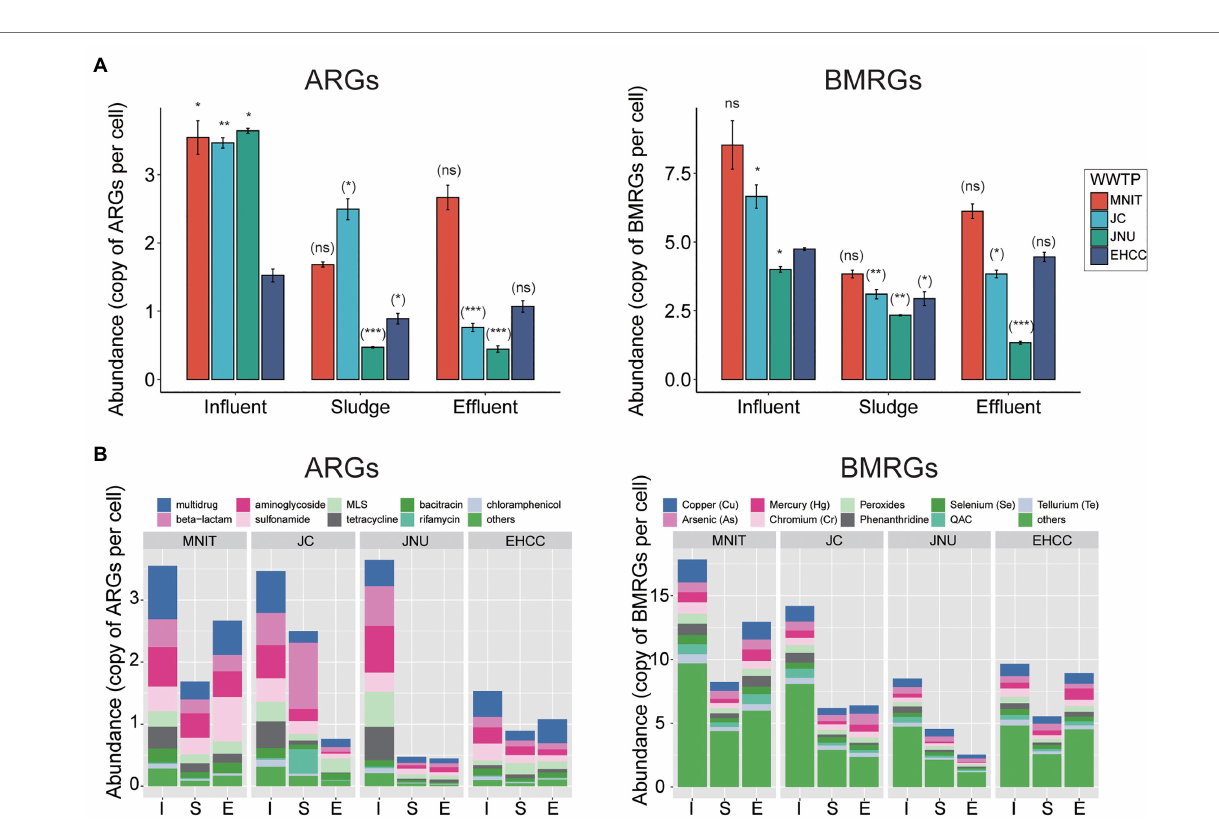
FIGURE 3 | The absolute abundance of ARGs and BMRGs based on subtypes (A) or types (B) . Data in (A) are mean ± standard deviation. Significances between the influents of MNIT/JC/JNU vs. influent of EHCC (outside brackets) and between influent and sludge/effluent for each WWTP (inside brackets) were indicated by using